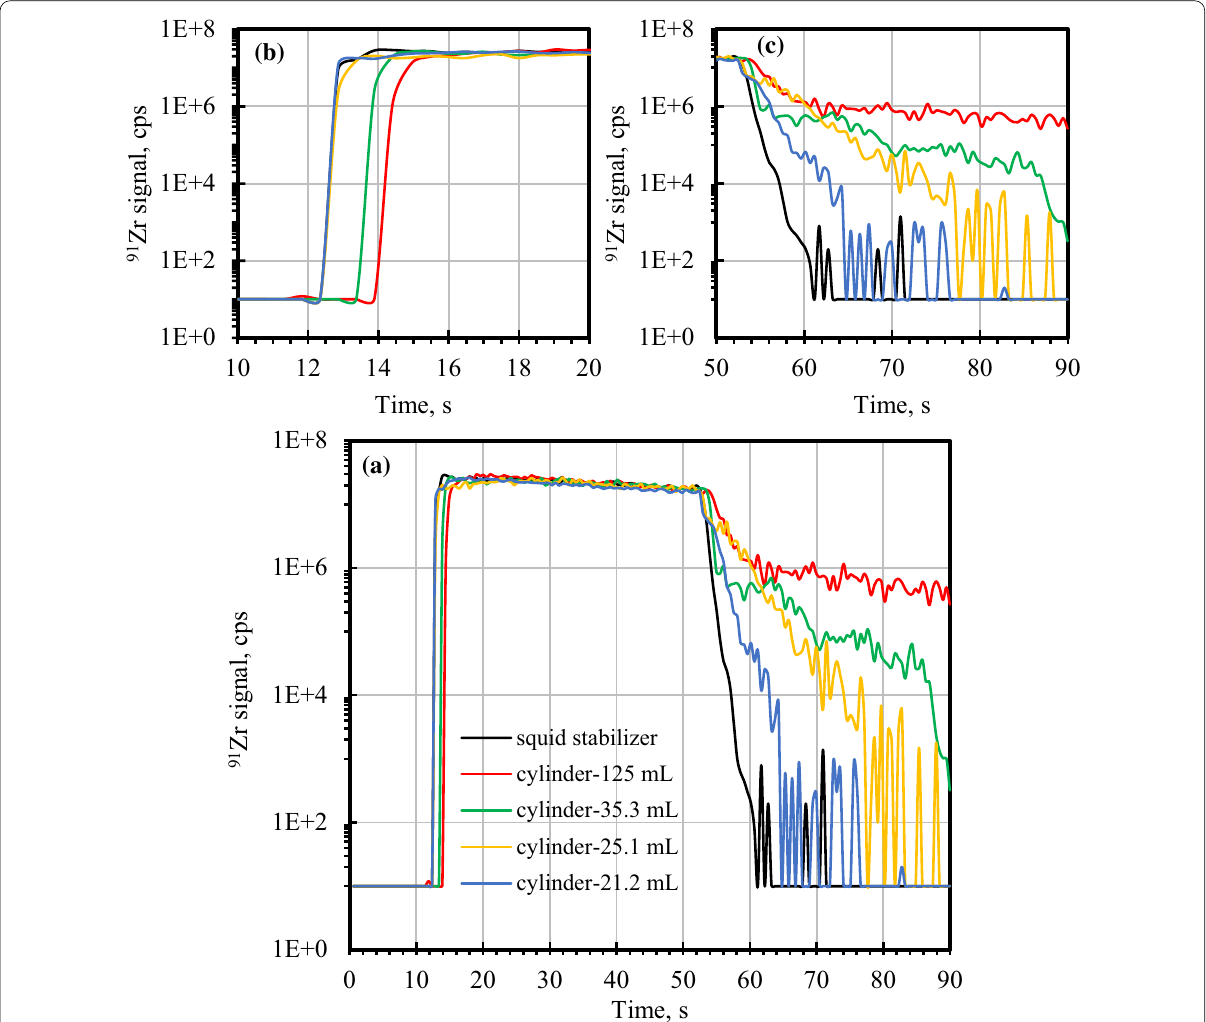
Fig. 2 Transient signal profiles of 91 Zr intensity of zircon standard 91500 with 35 μm of spot size and 5 Hz of laser repetition rate using “squid” signal stabilizer and cylinder stabilizers with different volumes. a Presented the signal profiles of 91 Zr versus assay time, while b , c Showed the signal rising and washout curves when using “squid” signal stabilizer and 21.2, 25.1, 35.3 and 125 mL of cylinder stabilizers,